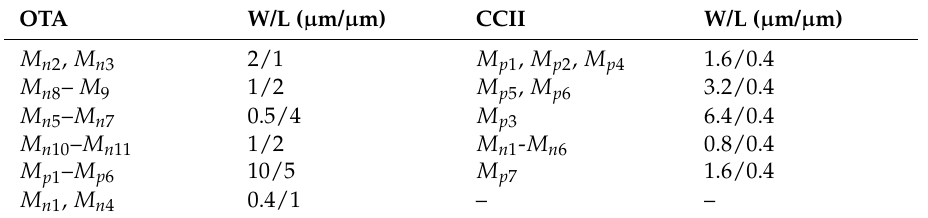
Table 5. MOS transistors dimensions—OTA and